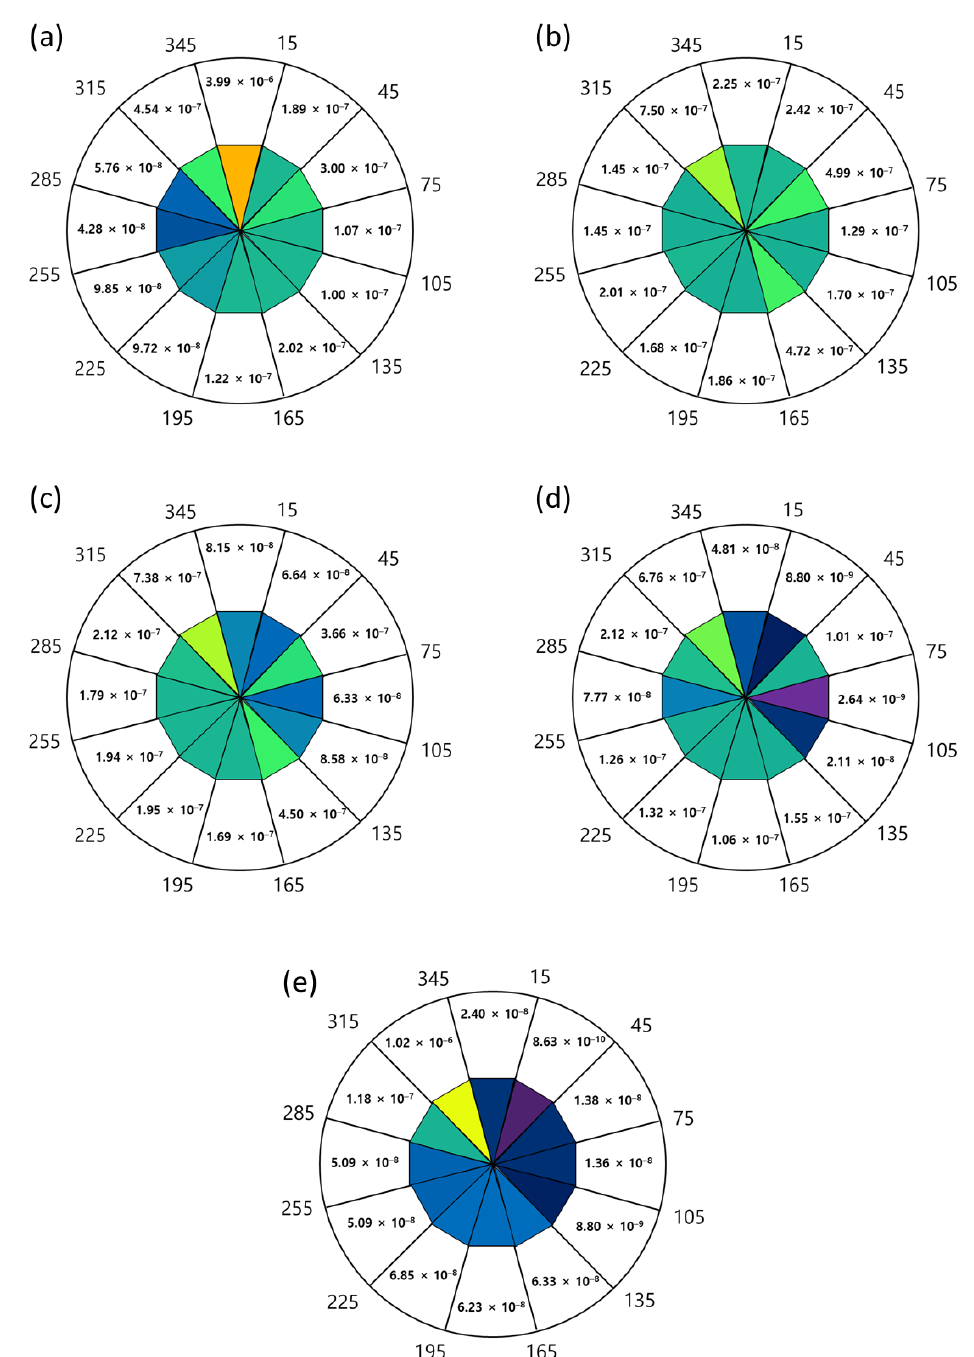
Figure 9. IR of 1% fatality at different wind directions and speeds: ( a ) 0–1 m/s, ( b ) 1–2 m/s, ( c ) 2–3 m/s, ( d ) 3–4 m/s, and ( e ) >4 m/s. The IR results were calculated for the areas corresponding to 99%, 50%, and 1% fatality in each wind direction. The total IR was calculated for each wind speed. For the case of 99% fatality, the highest IR was at 345 ◦ –15 ◦ for a wind speed of 0–1 m/s and at 315 ◦ –345 ◦ for wind speeds >1 m/s. The lowest IR was at 255 ◦ –285 ◦ for a wind speed of 0–1 m/s, 75 ◦ –105 ◦ for wind speeds of 1–4 m/s, and 15 ◦ –45 ◦ for wind speeds >4 m/s. For the case of 50% fatality, the highest IR was at 345 ◦ –15 ◦ for a wind speed of 0–1 m/s and 315 ◦ –345 ◦ for wind speeds >1 m/s. The lowest IR was at 255 ◦ –285 ◦ for a wind speed of 0–1 m/s, 75 ◦ –105 ◦ for wind speeds of 1–4 m/s, and 15 ◦ –45 ◦ for a wind speed >4 m/s. For the case